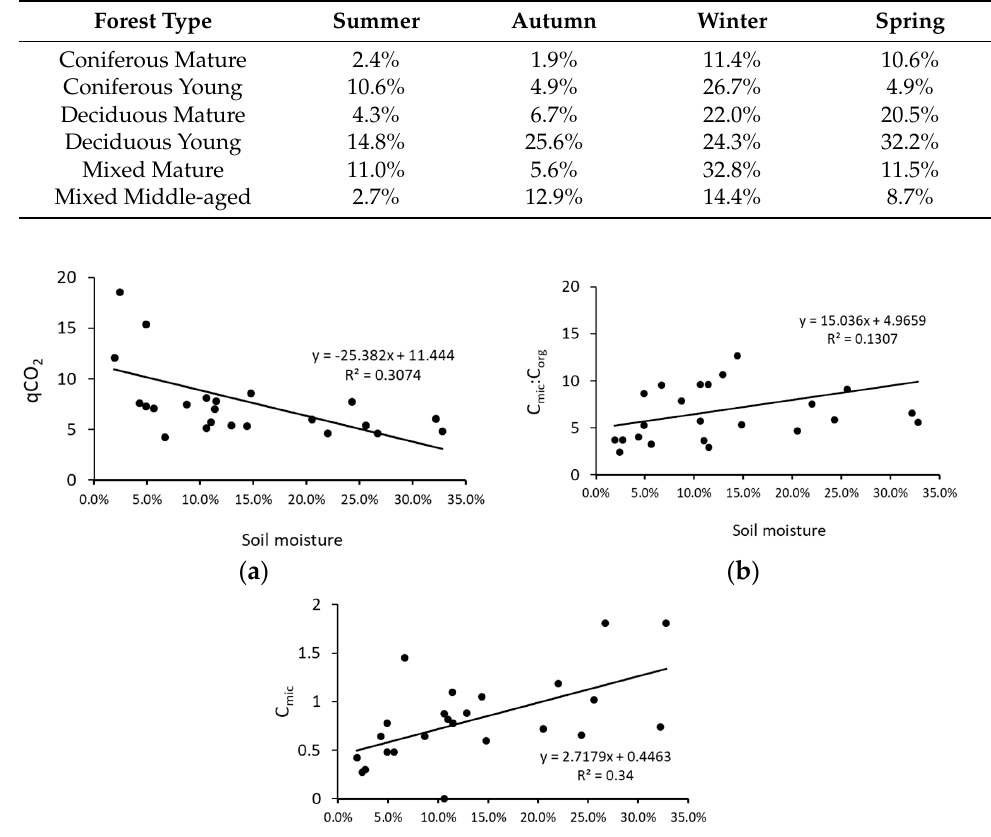
Table A1. Soil moisture content at the time of sampling tested soils [% v / v ].